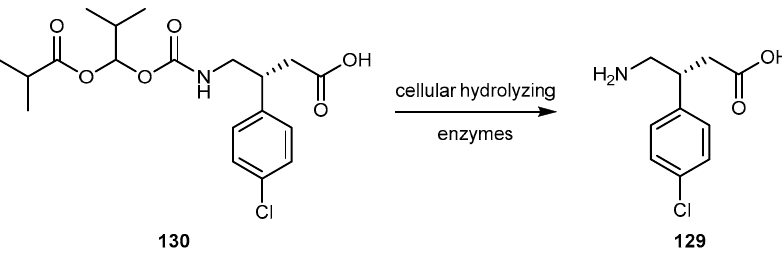
Figure 51. Bioconversion of XP19986 ( 130 ) to R -baclofen ( 129 ) by cellular hydrolyzing enzymes (adapted from [4]).